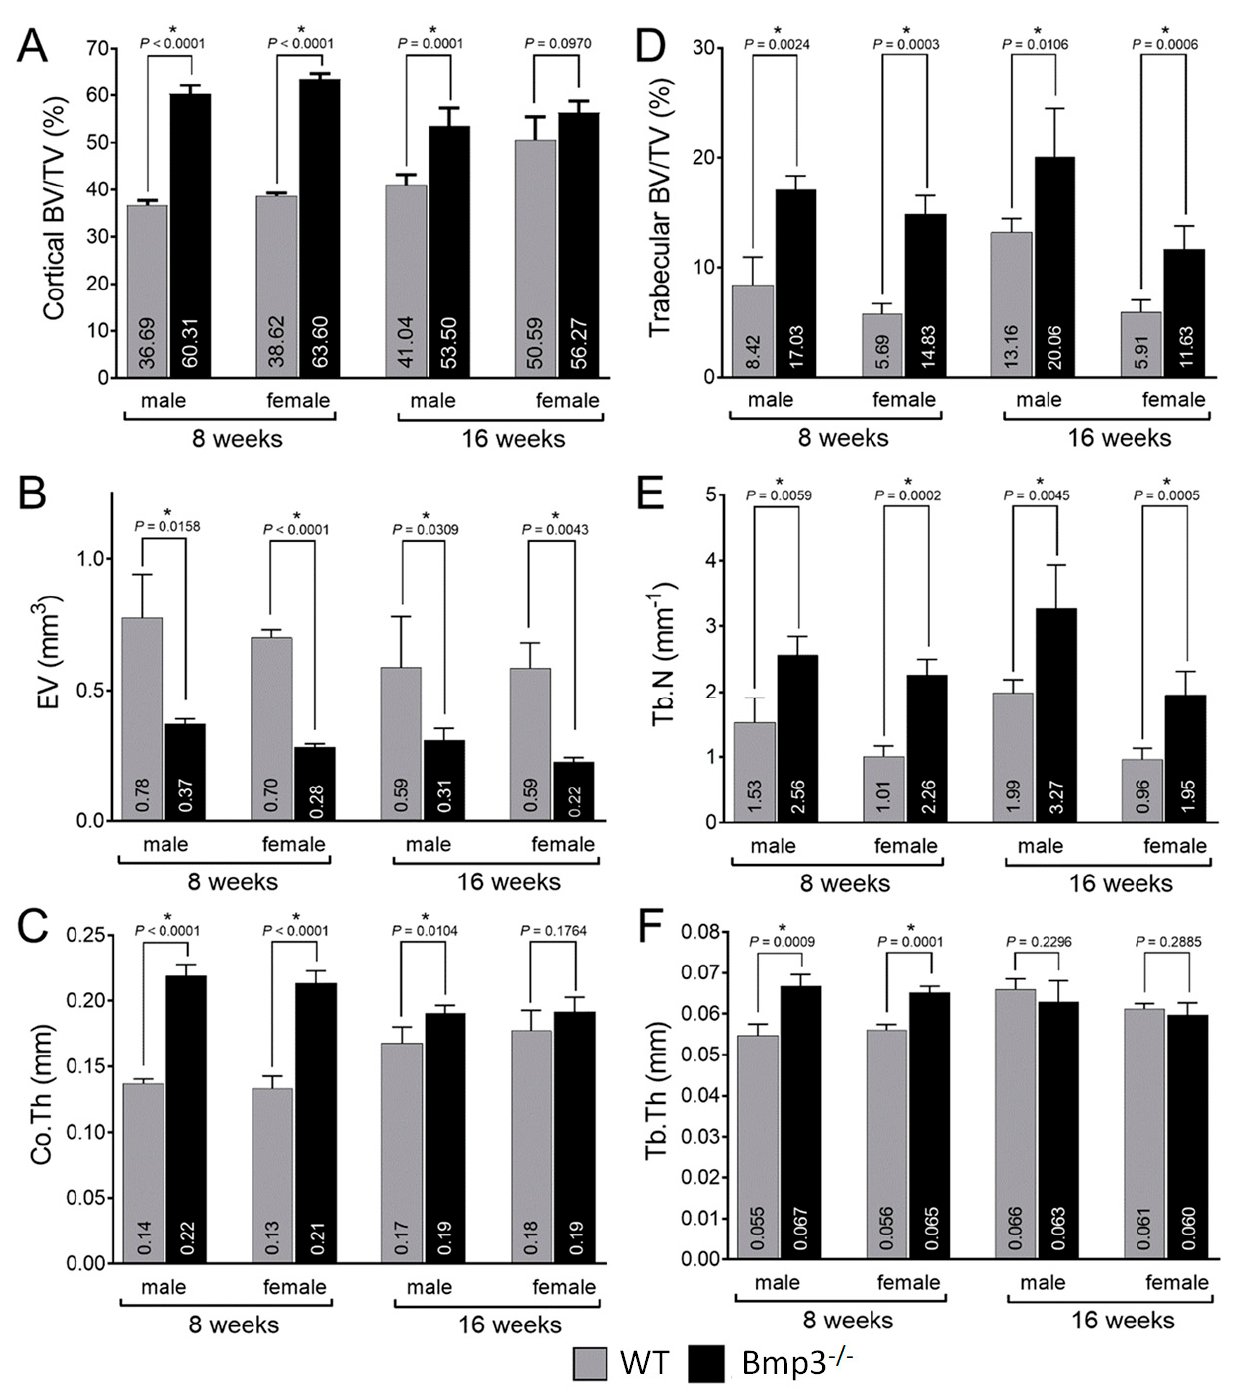
Figure 5. Morphometric analysis of the proximal tibia of Bmp3 − / − and WT mice at 8 and 16 weeks of age. ( A ) BV/TV, ( B ) EV and ( C ) Co.Th for tibial cortical bone. ( D ) BV/TV, ( E ) Th.N and ( F ) Tb.Th for tibial trabecular bone. Statistically significant differences are indicated by